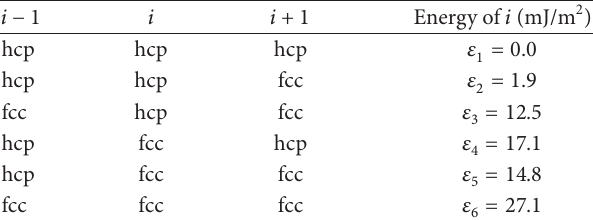
Table 2: The local environment of atoms 𝑖 and 𝑖 ± 1 ; hcp and fcc are atoms of local environment. The parameters 𝜀 1 to 𝜀 6 denote the energy of atom 𝑖